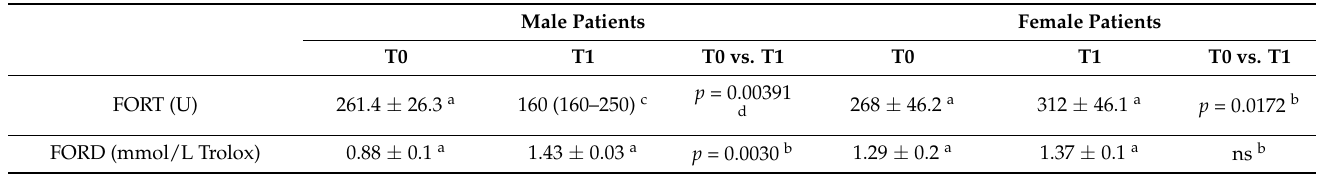
Table 7. Oxidative stress and antioxidant defense mechanism efficiency assessment of the OFS group.